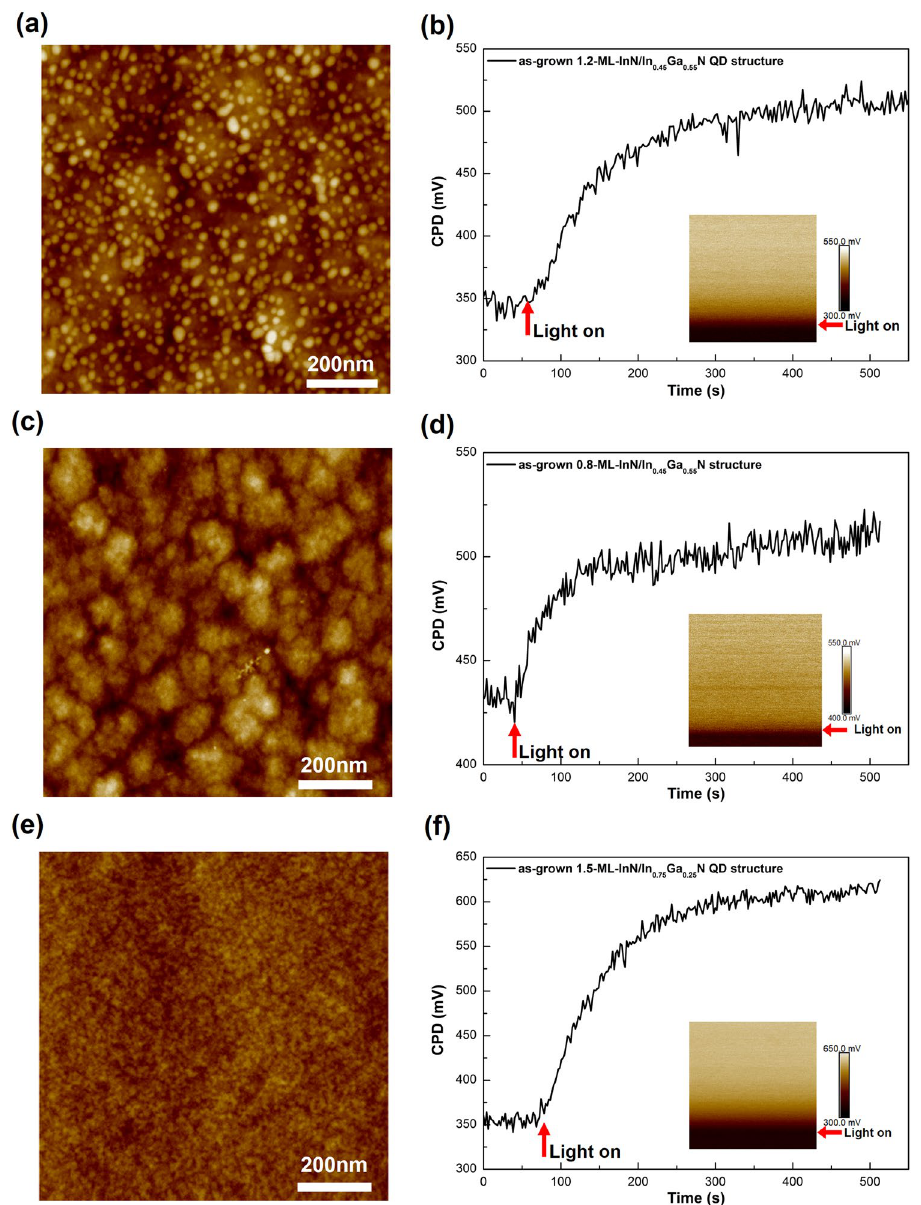
Figure 1. As-grown InN/InGaN structures. AFM height images and CPD as a function of time for the as- grown ( a , b ) 1.2-ML-InN/In 0.45 Ga 0.55 N QD structure, ( c , d ) 0.8-ML-InN/In 0.45 Ga 0.55 N structure and ( e , f ) 1.5-ML- InN/In 0.75 Ga 0.25 N QD structure. Insets in ( b , d , f ): KPFM CPD images. The arrows indicate the switching on of the light. The scan field is 1 × 1 µ m 2 and the full height contrast is 10 nm in all AFM